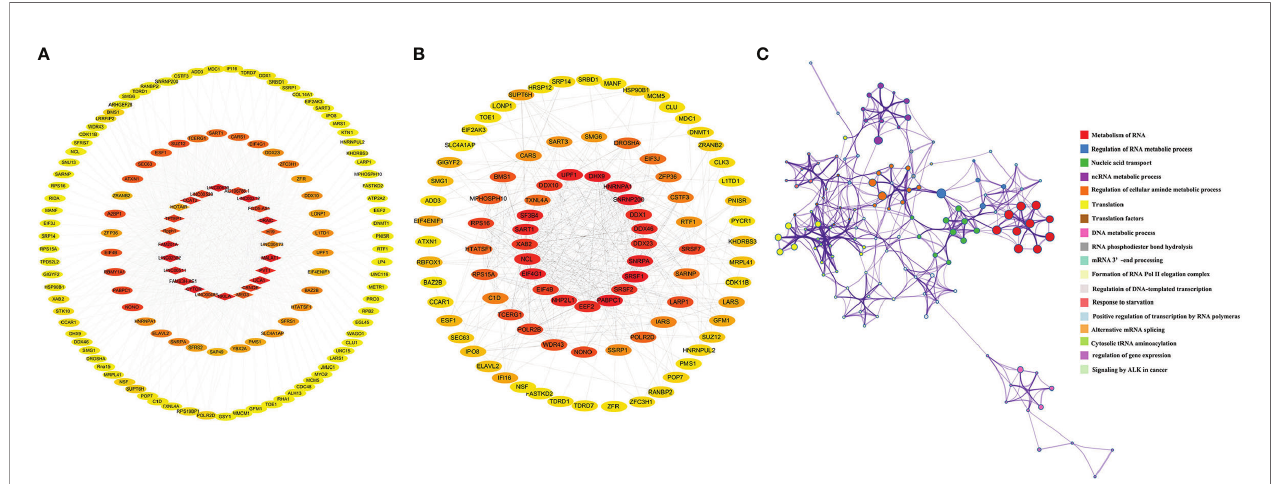
FIGURE 2 | The interaction network of targets protein and gene function prediction of lncRNAs pathways involved in radiosensitivity. (A) The interaction network of targets protein of lncRNAs from STRING database (https://www.string-db.org/). (B) Coexpression scores based on RNA expression patterns, and on protein co- regulation provided by STRING. (C) Gene network of enriched terms by Metascape (https://metascape.org/), a subset of enriched terms has been selected and rendered as a network plot, where terms with a similarity > 0.3 are connected by edges. We select the terms with the best p-values from each of the 20 clusters, with the constraint that there are no more than 15 terms per cluster and no more than 250 terms in total, where each node represents an enriched